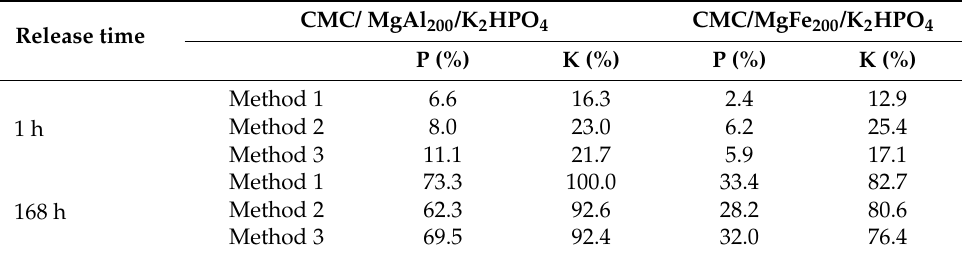
Table 4. Percentage release of the elements for CMC/MgAl 200 /K 2 HPO 4 and CMC/MgFe 200 /K 2 HPO 4 composites. CMC/ MgAl 200 /K 2 HPO 4 CMC/MgFe 200 /K 2 HPO 4 Release time P (%) K (%) P (%) K (%) 1